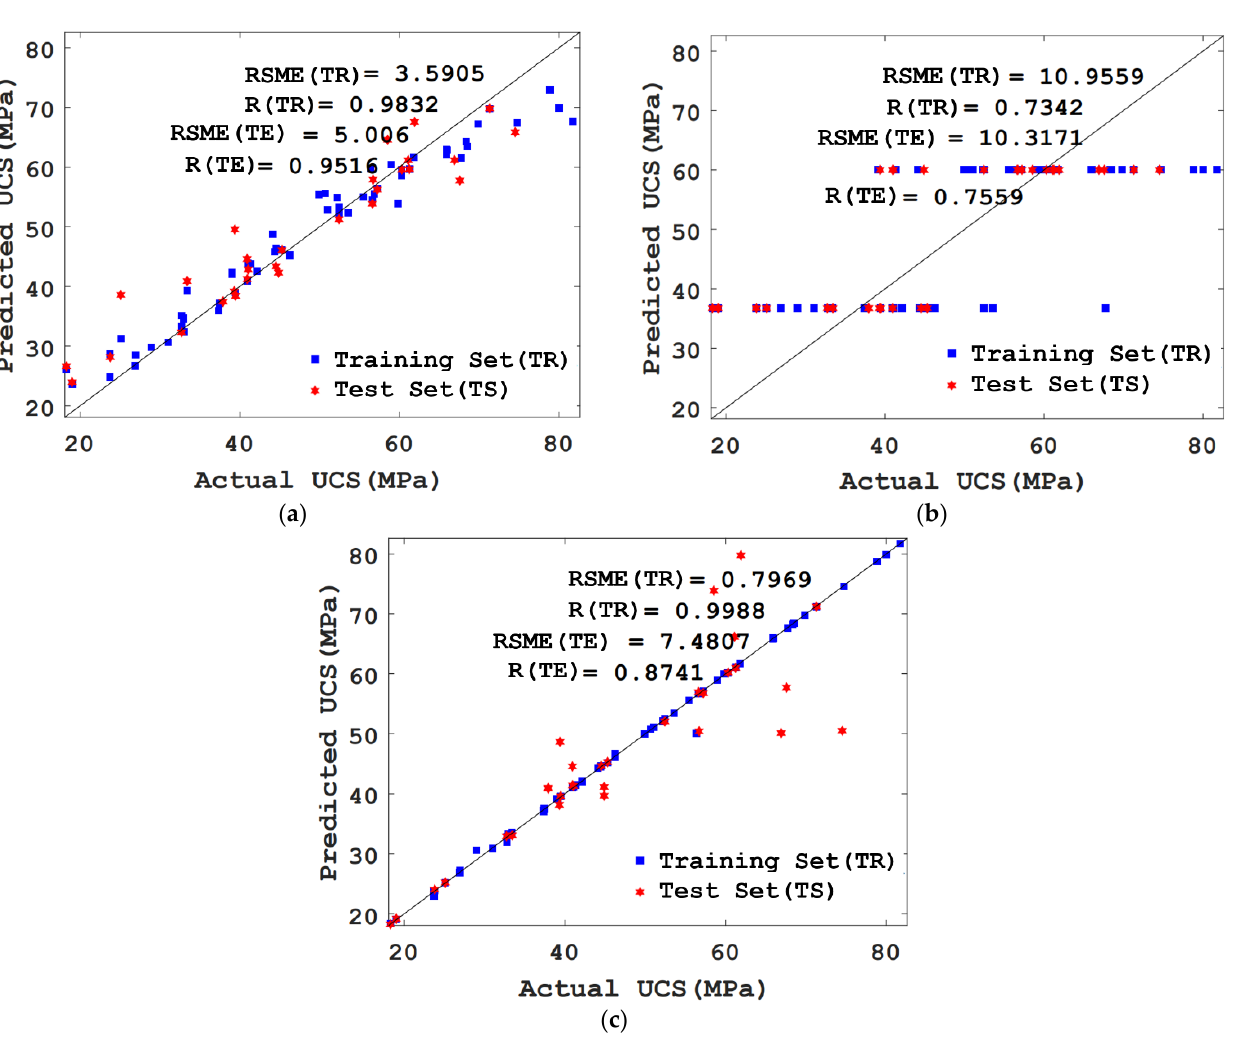
Figure 7. Comparison of prediction effects of different models on UCS of concrete. ( a ) RF model; ( b ) DT model; ( c ) SVM model.